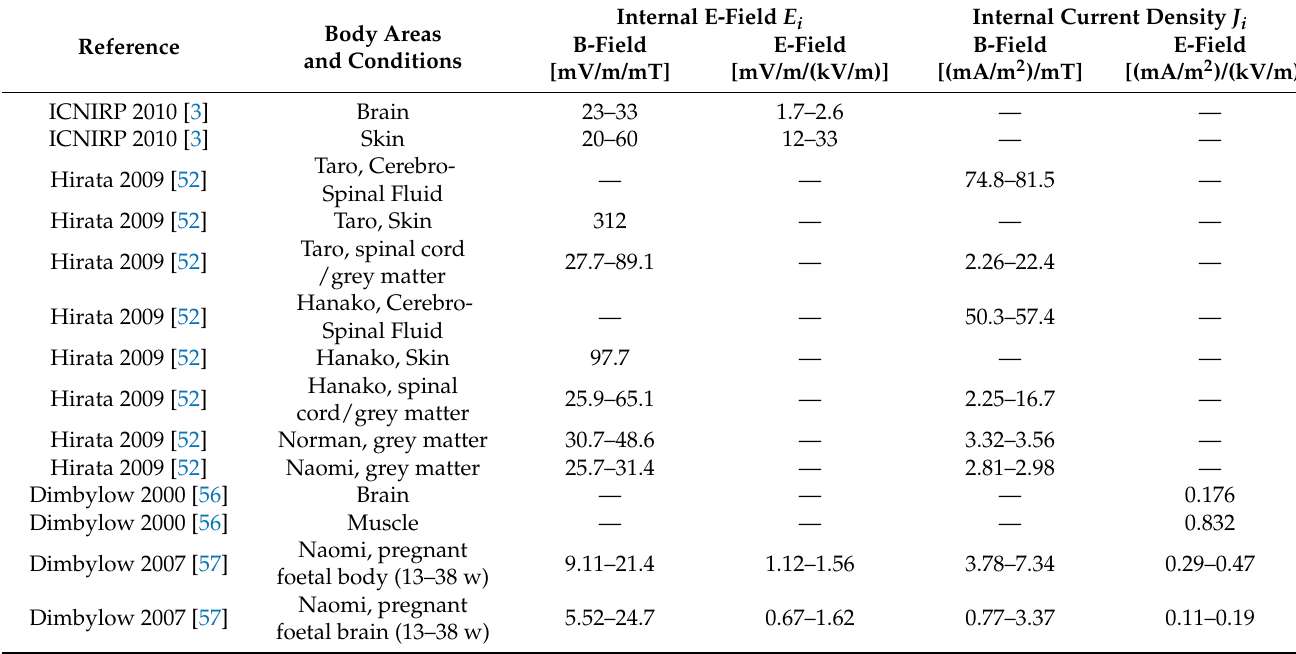
Table 2. Conversion factors between external field at 50 Hz and internal quantities ( E i and J i ) as resulting from various types of models